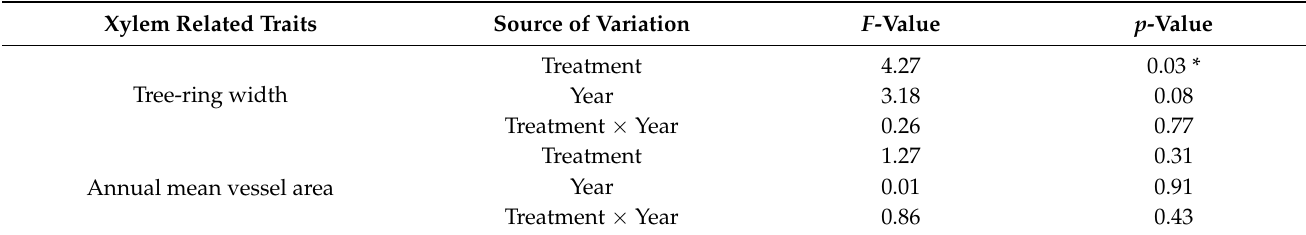
Table 2. ANOVA results showing effects of nitrogen (N) addition treatments, year and their interaction effects on xylem-related traits in Quercus variabilis Blume during 2013–2018 in Central